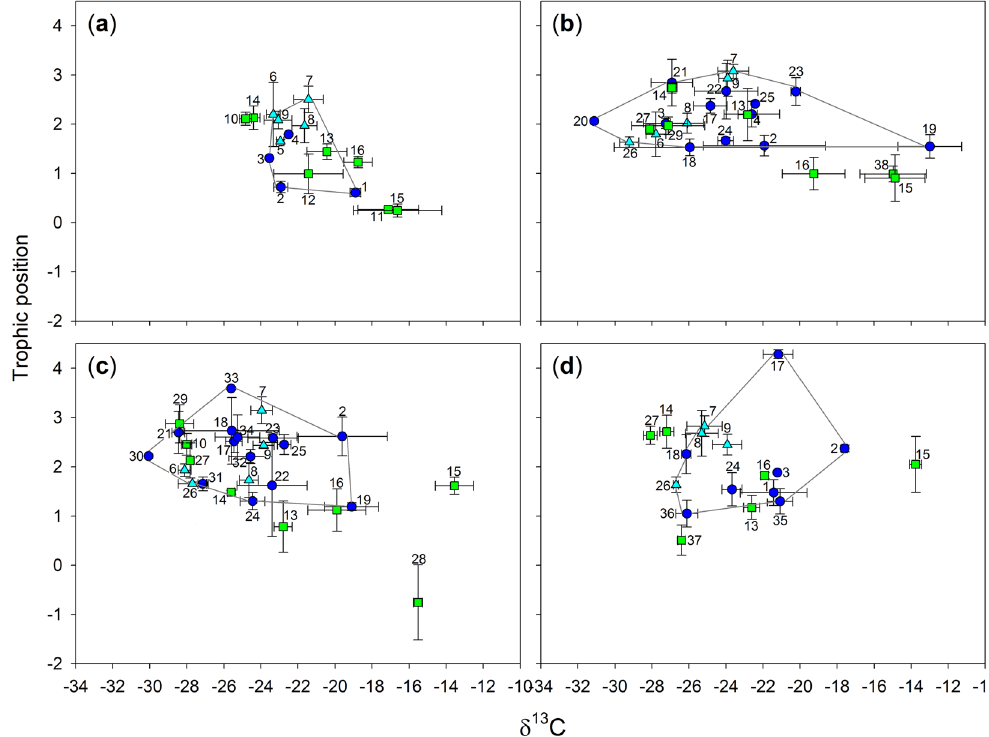
Figure 1. Stable isotope-based biplots of trophic position inferred from δ 15 N vs δ 13 C values over the course of a hydroperiod: ( a ) survey 1, ( b ) survey 2, ( c ) survey 3, and ( d ) survey 4 showing the convex hull areas encompassing all invertebrate taxa. For each sample point, n = 2–17 individuals and error bars represent ± standard deviations, green squares – plants (i.e. macrophytes, POM, detritus), dark blue circles – macroinvertebrates, light blue triangles – zooplankton. Taxa names for invertebrates see Table 1, 10 – Cyperus marginatus , 11 – detritus, 12 – filamentous algae, 13 – POM, 14 – Marsilea spp., 15 – Sporobolus africanus , 16 – sediment, 27 – Crinium spp., 28 – Euglenophyta, 29 – Persicaria spp., 37 – Laurembergia repens subsp. brachypoda , 38 – horse